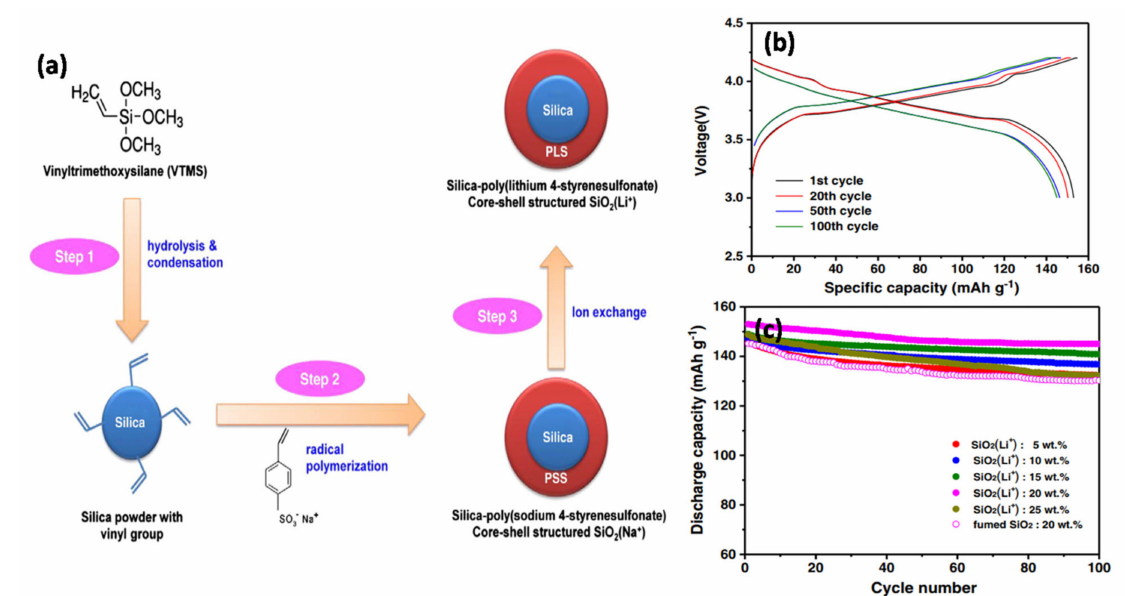
Figure 13. ( a ) Reaction scheme for the synthesis of the SiO 2 (Li + ) particles. ( b ) Charge-discharge curves of the GPE containing 20 wt.% SiO 2 (Li + ) particles. ( c ) Discharge capacities of the GPE containing different contents of SiO 2 (Li + ) particles. Reprinted with permission from Kim et al. [108]. Copyright 2012 Elsevier B.V.